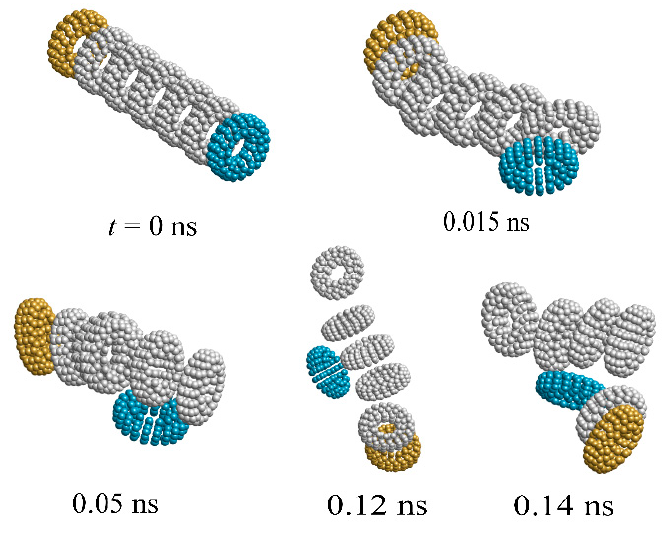
Figure 7. Demonstration of the π -rotation effect and rearrangement of a cluster of 7 molecules. Chaotic translational and rotational vibrations initiate directional movement not only through the collective effect of cluster rotation. The cluster of nanotori also generates a directed rotational motion of each molecule around its ζ k -axis, which for brevity, we will call 2 π -rotation. Consider a group consisting of S = 5 toroidal molecules. Figure 8 shows the time dependence of the magnitude of the angular velocity com- ponent ( r ) along the ζ k -axis. It can be seen that in the molecules with the number k = 1, 4 have a predominantly positive value of r , and the molecules with the number k = 2, 5 have a negative value of r . Moleculewith number k = 3 changes the direction of 2 π -rotation from positive to negative when performing collective π -rotation. The maximum frequency of the 2 π -rotation is observed for the first torus and is 19.9 GHz. Note that researchers using molecular dynamics methods also observed frequencies in the gigahertz range for